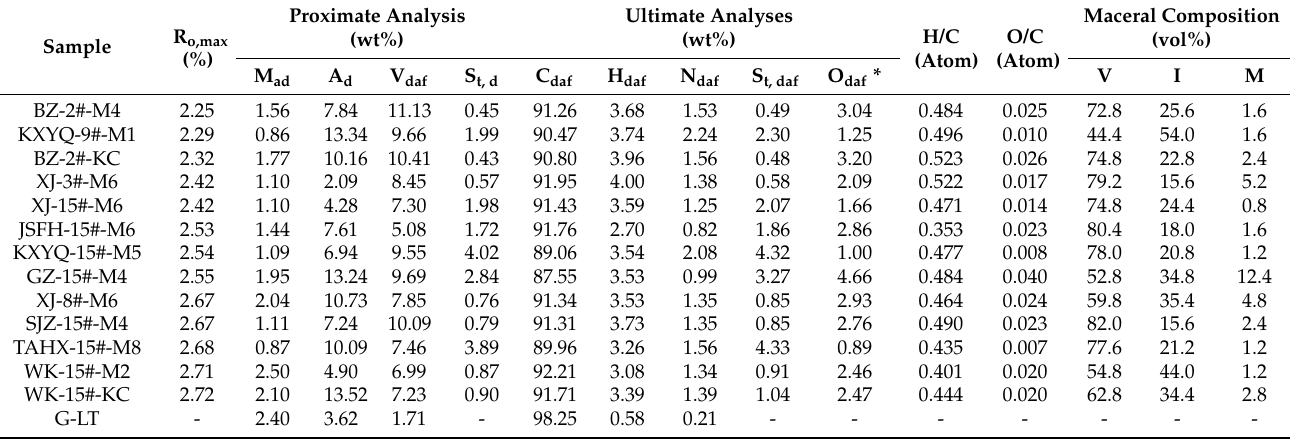
Table 2. Basic characteristics of samples